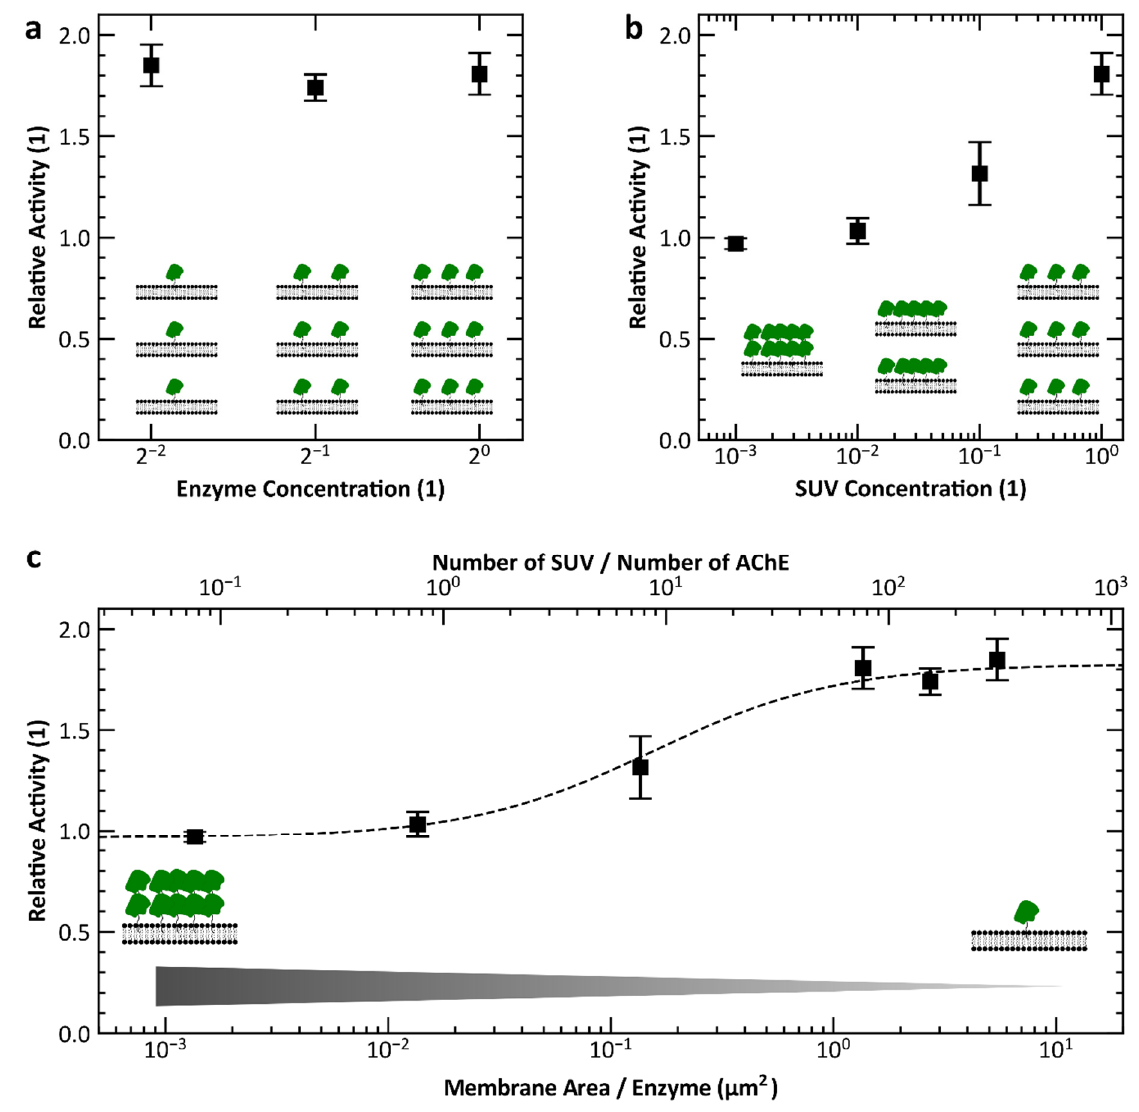
Figure 10. Influence of the available lipid membrane area on enzyme activity. ( a ) At a lipid concentration of 1 mg/mL, there is a significant increase in enzyme activity compared to the free enzyme (relative activity = activity with lipid/activity free enzyme). This effect is independent of the enzyme concentration. ( b ) If the lipid concentration is reduced, the effect decreases. At a 1000-fold reduction in lipid concentration, increased enzyme activity is no longer observed. ( c ) Relative activity as a function of available membrane area per enzyme calculated from ( a ) and ( b ). Error bars represent the standard error of the mean, n = 3.